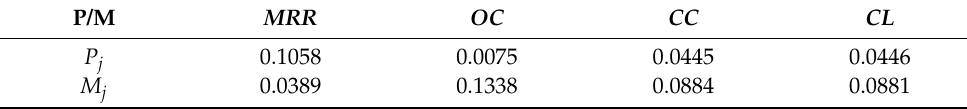
Table A4. Positive and negative ideal